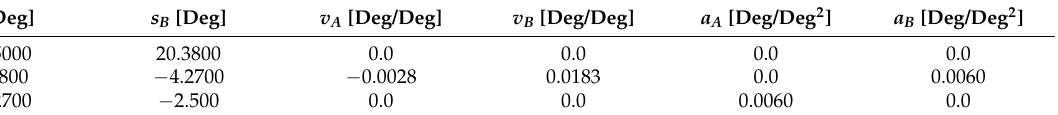
Table 8. Constraints’ values for each phase of the considered actual case.